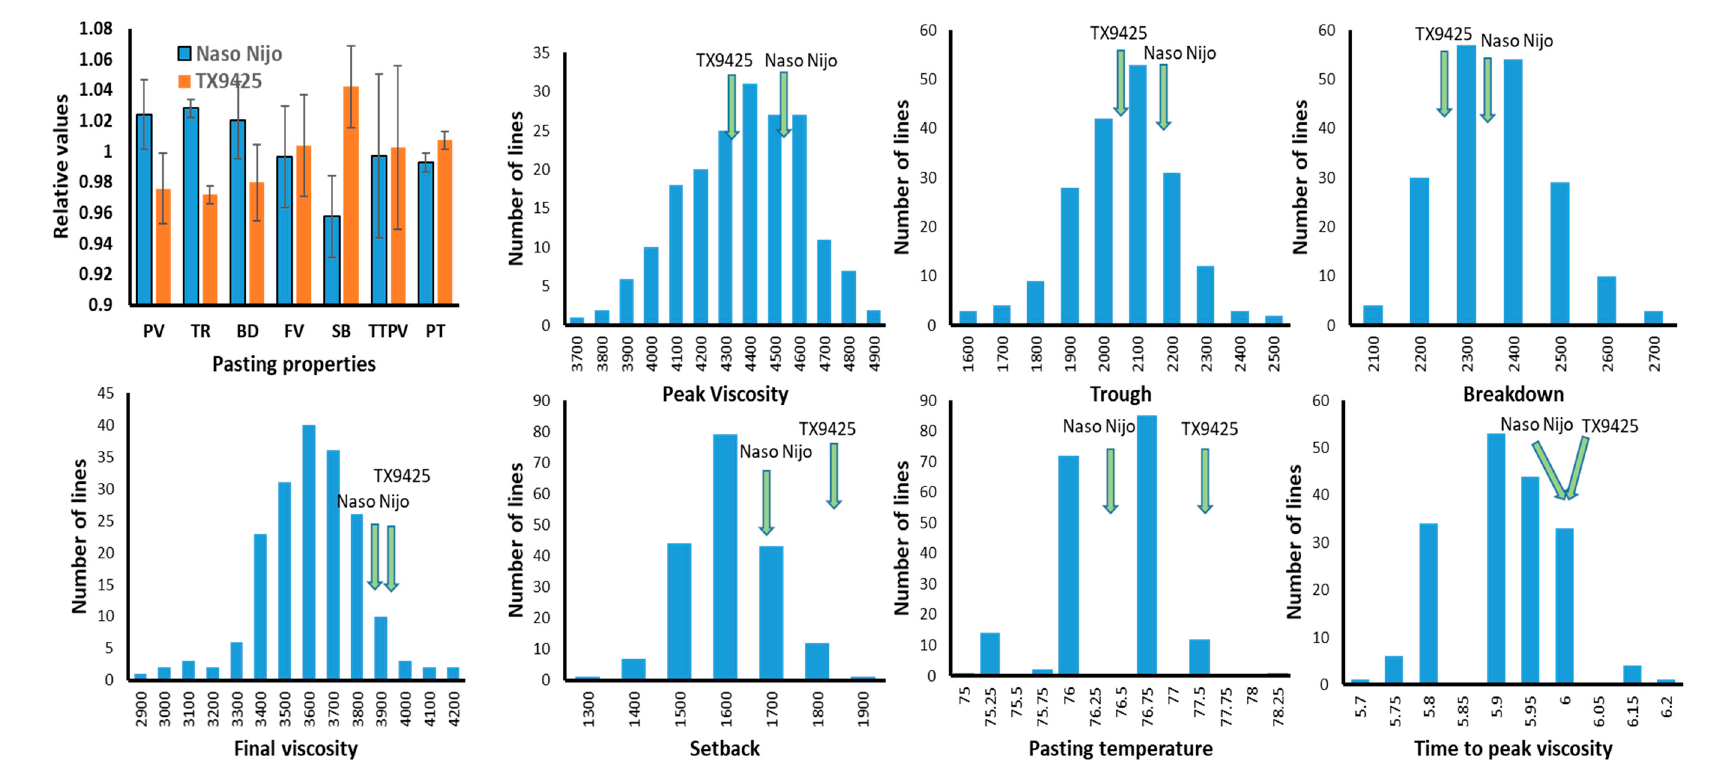
Figure 1. Distribution of different pasting properties in the DH population between the cross of TX9425 and Naso Nijo. Green arrows indicate the value s of two parents.